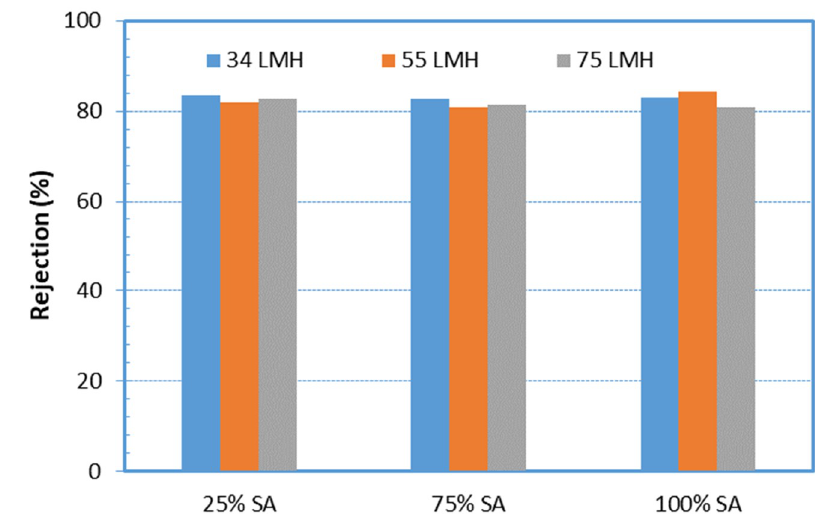
Figure 12. Protein rejection during filtration of feed-solutions, prepared by an alternative protocol, for various foulants composition and permeate fluxes.